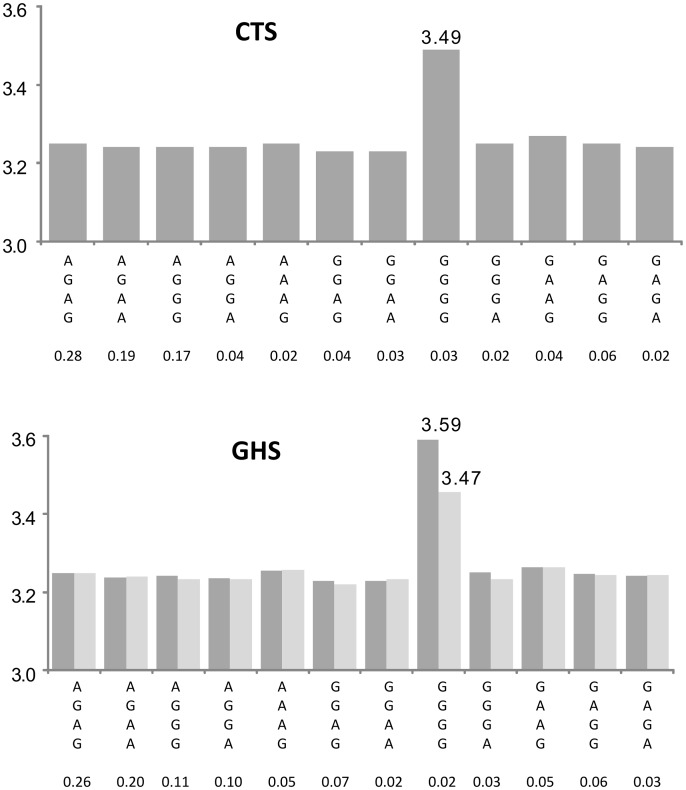
Association between ILMN_1757379 (OPN1SW) expression and the haplotypes derived from rs1109552, rs4731507, rs4731513, and rs339088.The top panel shows the results in the discovery cohort CTS and the bottom panel in the replication cohort GHS. Each bar corresponds to the expected mean of gene expression associated with one dose of the corresponding haplotype under the assumption of additive haplotype effects. According to this model, the expression level of an individual is the sum of the levels of his (her) two haplotypes. Haplotype frequencies are indicated under each haplotype label. In CTS, the rs4731507 and rs339088 were substituted by their perfect proxies (r2 = 1) rs4283986 and rs339085, respectively. The original haplotypic association (dark grey bars) was due to a unique rare haplotype derived from 4 common htSNPs. This rare haplotype, GGGG, was associated with a strong increase in OPN1SW expression (β = +0.240, p = 8.12 10−26 and β = +0.341, p<10−307 in CTS and GHS, respectively). After adjusting in GHS for the best imputed cis eSNP rs142976957 (light grey bars), the effect of this rare haplotype was still highly significant (β = +0.208, p = 4.78 10−135).